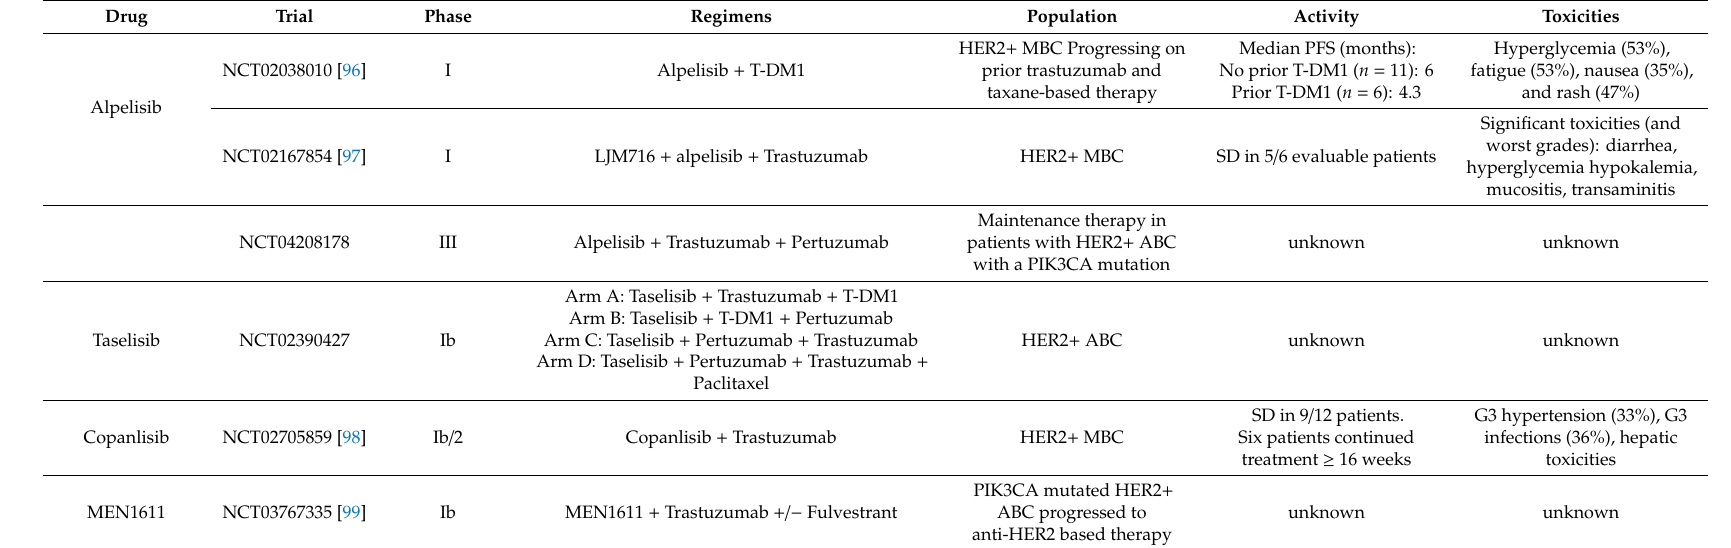
Table 6. Available clinical trials evaluating the safety and the e ffi cacy of PI3K inhibitors in combination with anti HER2